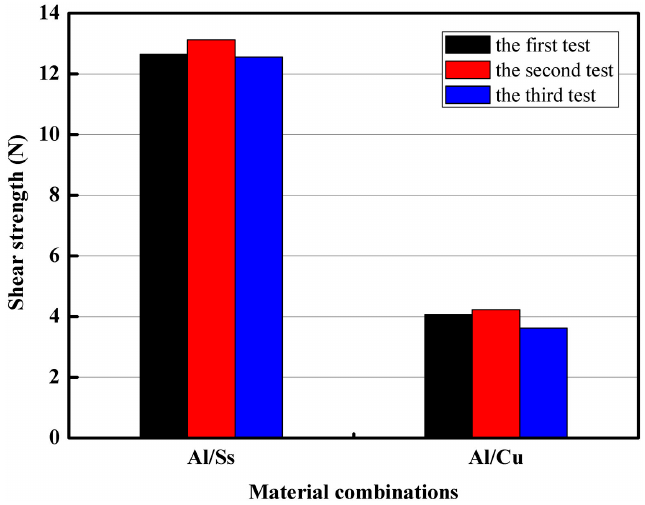
Figure 15. Shear strength of all the performed tests of different material combinations.